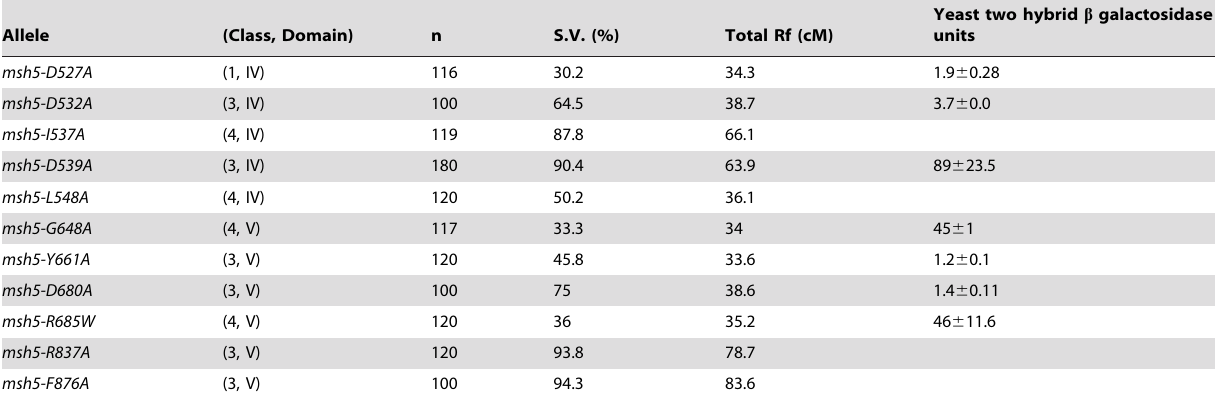
Percent spore viability and the genetic map distance (sum of four genetic intervals, URA3-LEU2 , LEU2-LYS2 , LYS2-ADE2 , ADE2-HIS3 ; [24]) from single spores are shown for each of the fifty-seven msh4 and msh5 alleles. Amino acid substitutions indicate the wild-type residue, amino acid position, mutation. The different classes indicate; 1: amino acids conserved in Msh4 and Msh5 in five species ( S. cerevisiae , A. thaliana , C. elegans , M. musculus and H. sapiens ) but absent in S. cerevisiae Msh2, Msh3, Msh6. 2: amino acid residues conserved in Msh4 only across five species. 3: amino acid residues conserved in MSH5 only across five species. 4: amino acid residues conserved in Msh4 and Msh5 across five species as well as in S. cerevisiae Msh2, Msh3 and Msh6. Mutations were also mapped with respect to specific domains in Taq MutS. msh4- G639A and msh5-G648A are analogous to Msh2 ATP binding mutations [55]. msh4-R676W and msh5-R685W are analogous to Msh2 and Msh6 ATP hydrolysis mutations [53]. Recombination frequencies (recombinant spores/total spores) were multiplied by 100 to obtain genetic map distance in centimorgans (cM). The total number of tetrads dissected (n) for each mutant is shown. Wild-type and msh5 D data are from Argueso et al. [24]. Yeast two-hybrid analysis was performed for the indicated msh4 and msh5 mutants. b -galactosidase activity (Miller units 6 standard deviation) from three independent co-transformants involving the msh4 and msh5 mutants and the corresponding wild-type MSH4 or MSH5 partner is shown. mutations ( msh4/5-t ) near the threshold limit for crossovers included msh4-E276A , msh4-F491A , msh4-N532A , msh4-R676W ,